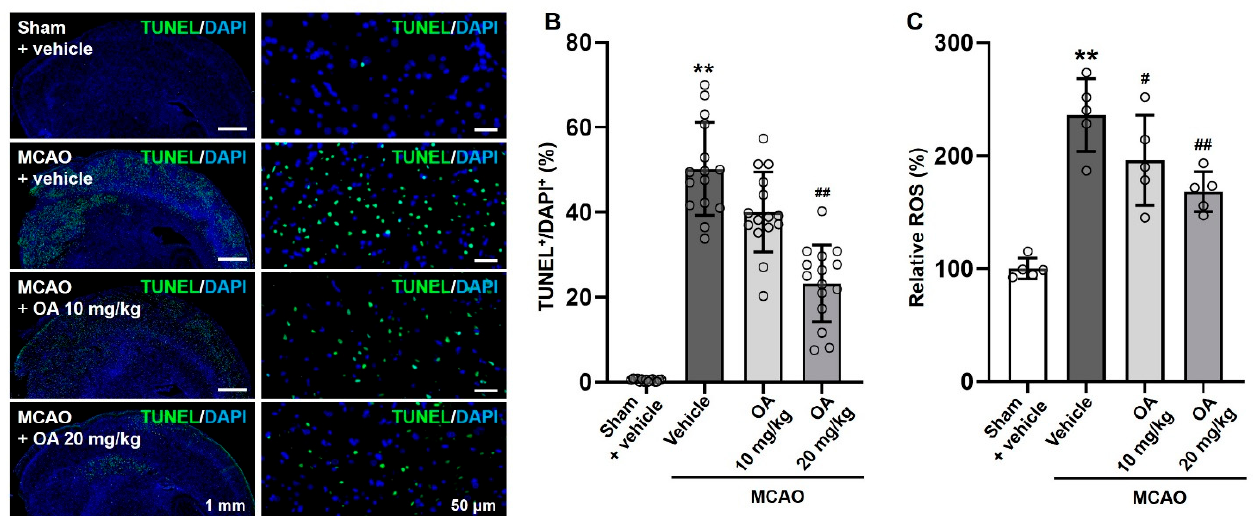
Figure 5. OA administration regulated GSK-3 β /HO-1 signaling pathway. ( A ) Representative protein bands and quantita- tive analysis of the ( B ) p-GSK-3 β (Ser9)/GSK-3 β ratio and ( C ) HO-1 protein expression levels, as assessed by Western blots, in the infarcted tissue of MCAO rats with or without OA administration. Data are shown as the mean ± S.D. # p < 0.05 and ## p < 0.01 versus the MCAO + vehicle group.